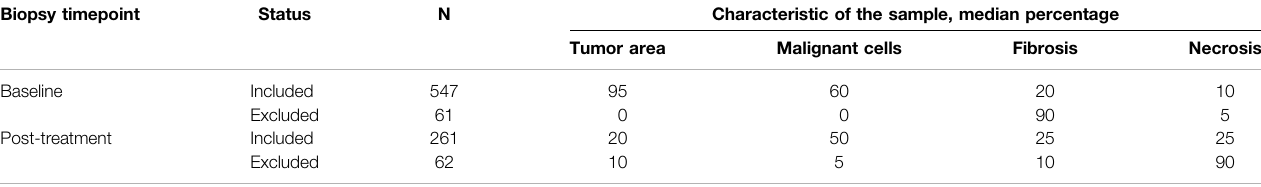
TABLE 1 | General overview of pathology quality control characteristics in our cohort ( N (cid:1) 931) divided by baseline ( N (cid:1) 608) and post-treatment ( N (cid:1) 323) core needle biopsies. Biopsy timepoint